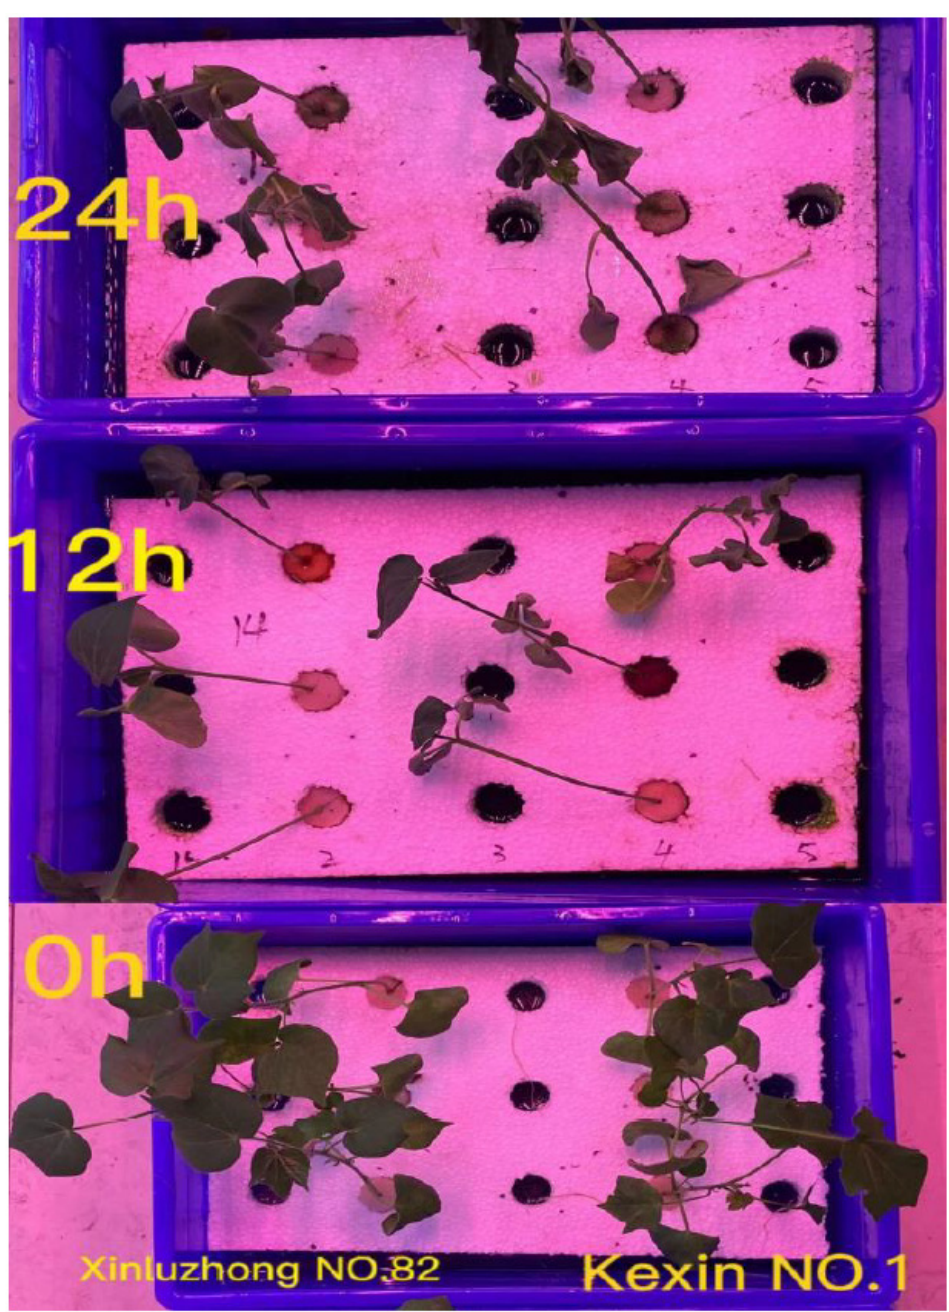
Figure 1. The performance of Xinluzhong No. 82 and Kexin No. 1 under seedling drought stress.